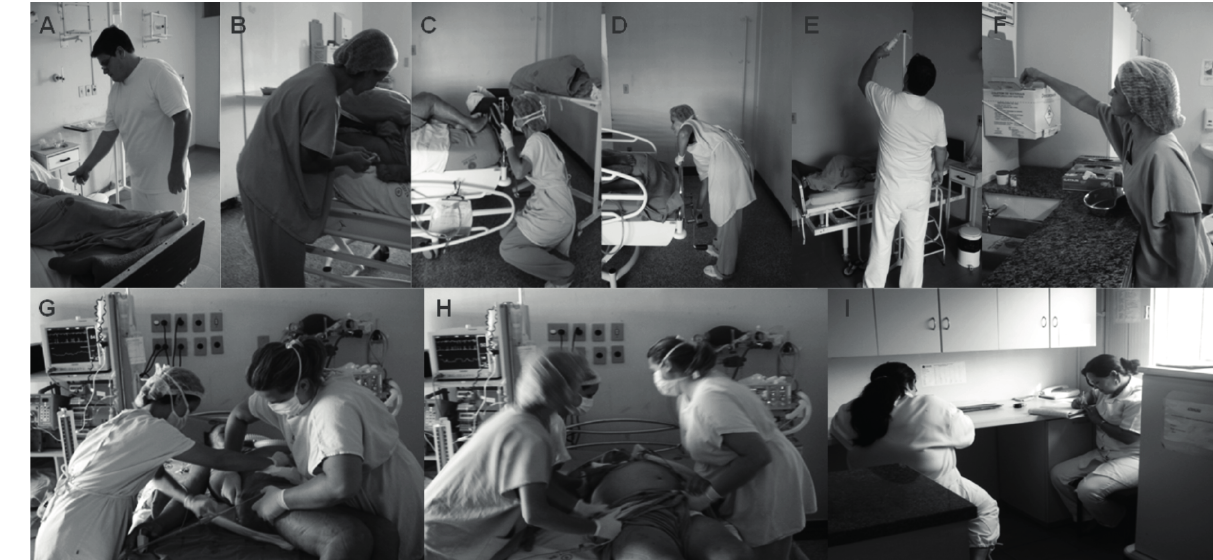
Figure 2 - Postures evaluated by the REBA protocol